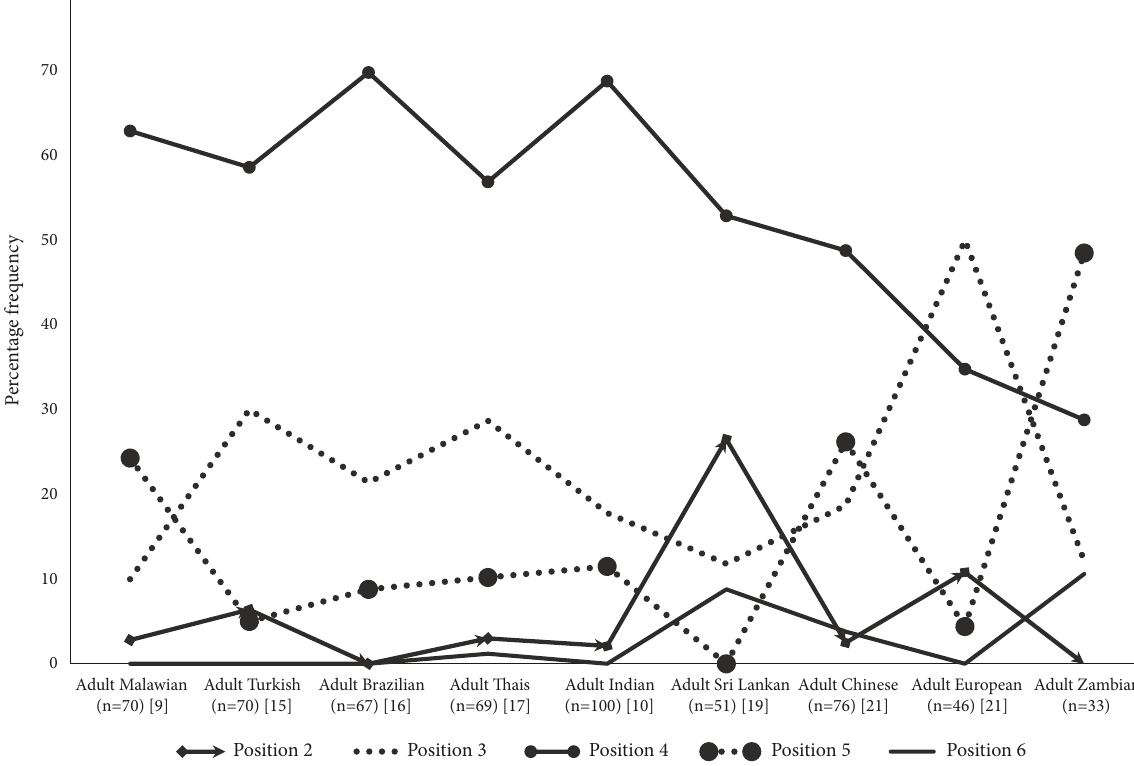
Figure 4: The position of MF in relation to mandibular teeth among different ethnic groups on different geographic locations: comparative analysis (frequency in percentage) with other reported values. Position 2: in line with the first premolar, position 3: between the first and second premolar, position 4: in line with second premolar, position 5: between the second premolar and first molar, and position 6: in line with the first molar. Table 4: Frequency distribution of MF and AMF directions of opening in Zambian adult human mandibles (n=33). Left side Right Direction of opening